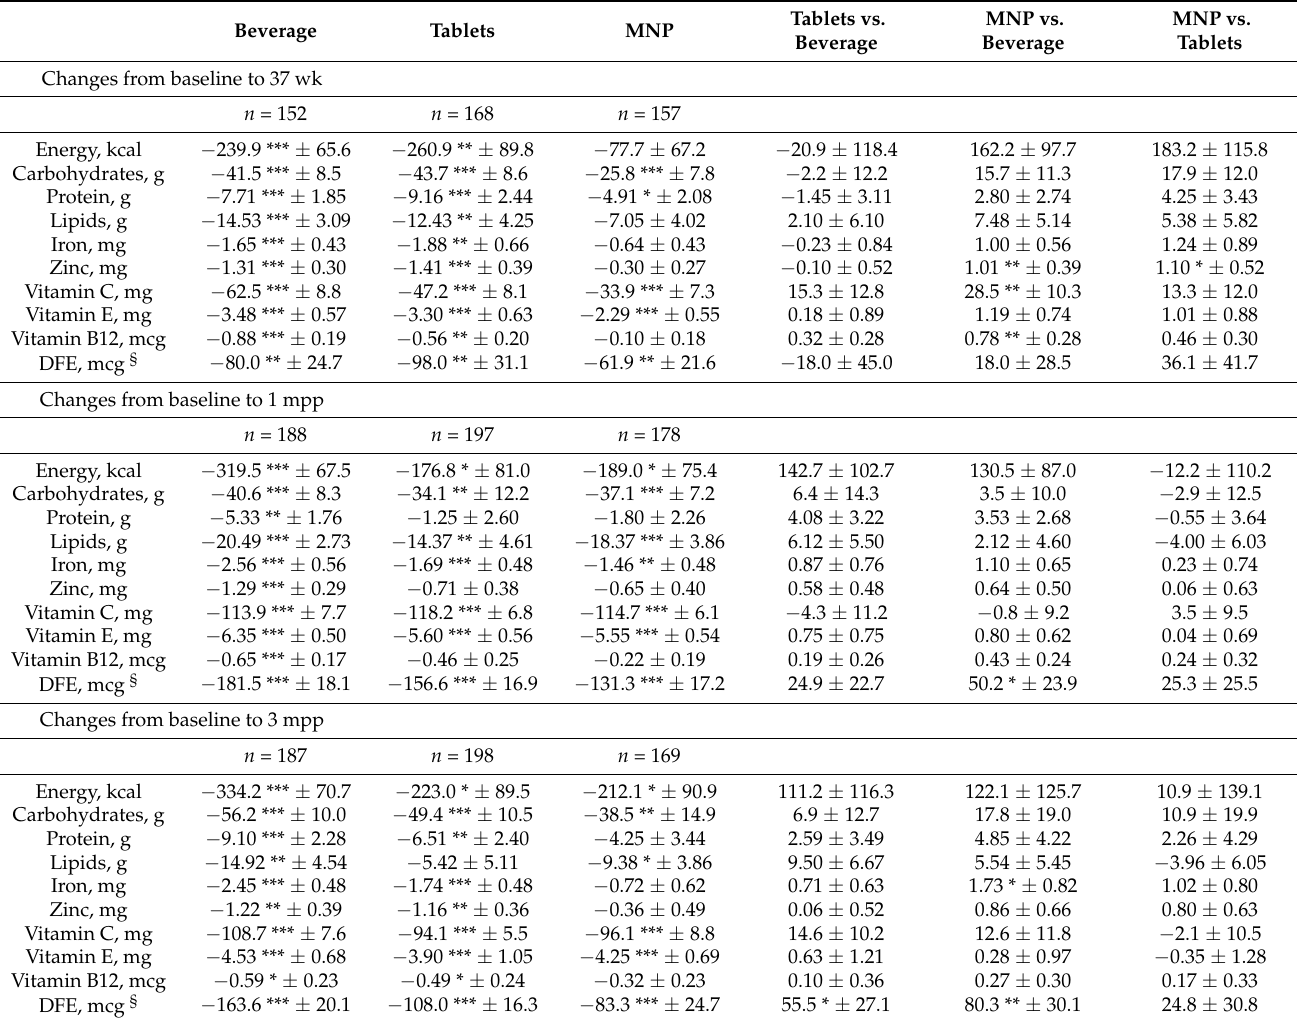
Table 3. Covariate-adjusted median changes † of nutrient intake from diet alone, by evaluation study groups ‡ and period Φ